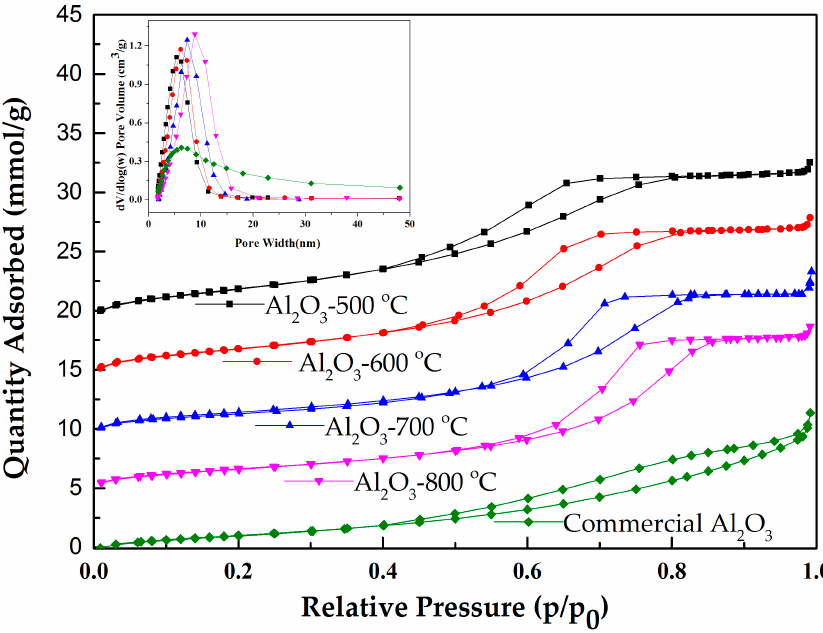
Figure 1. Nitrogen adsorption ‐ desorption isotherms curves and pore distribution of mesoporous alumina with different calcination temperature. Isotherms curves are on the same scale and offset vertically for clarity.